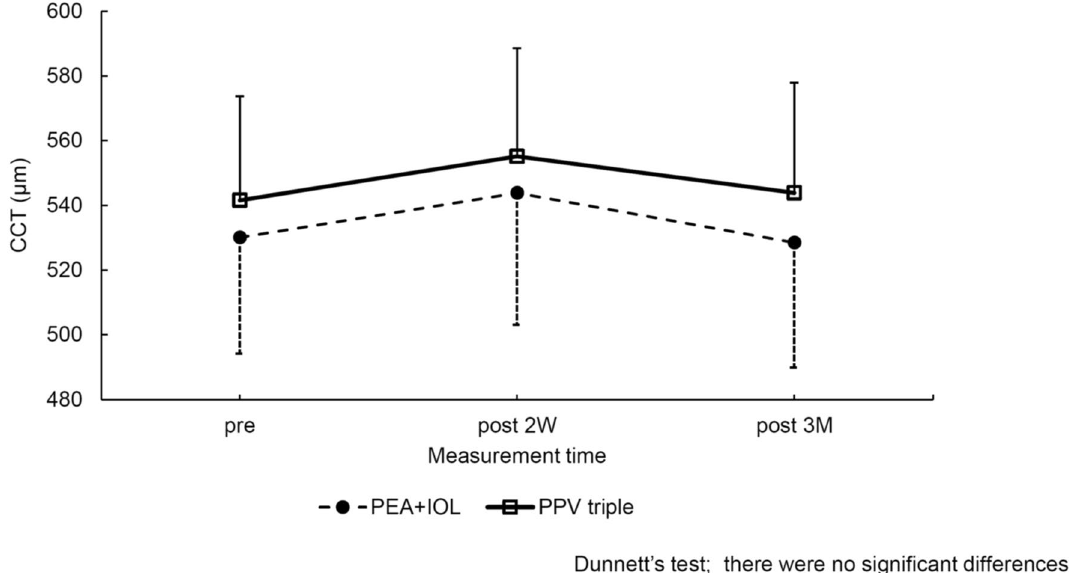
Figure 3. The CCT of the PEA + IOL group was 530.1 ± 35.9, 543.8 ± 40.7, and 528.5 ± 38.6 μm, the PPV triple group was 541.5 ± 32.2, 555.1 ± 33.5, and 543.8 ± 34.1 μm, preoperatively, 2 weeks, and 3 months after surgery, respectively. There was no significant difference in postoperative compared to preoperative CCT in both groups (p > 0.05).